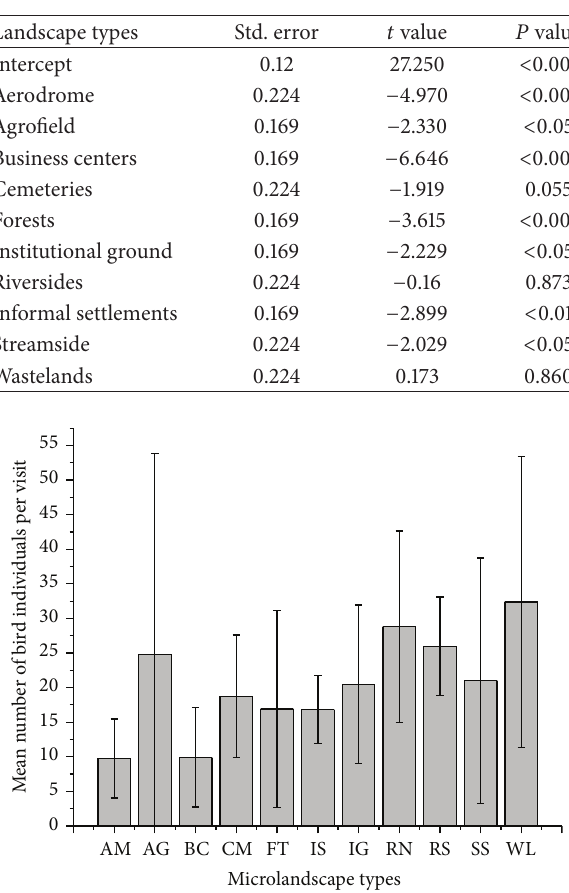
Table 3: LMM output showing parameter estimates of microland- scape types on the number of bird individuals.